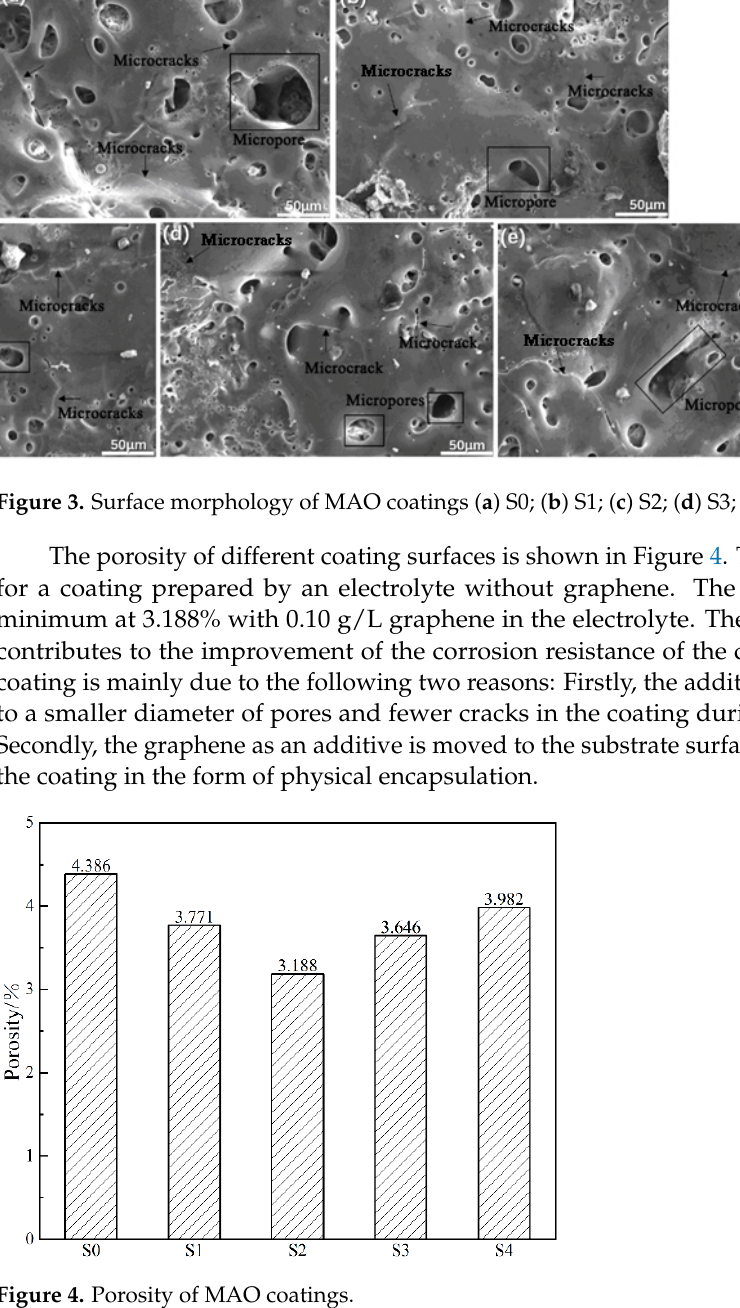
Figure 5. Cross-section morphology of MAO coatings ( a ) S0; ( b ) S1; ( c ) S2; ( d ) S3; ( e ) S4. 3.3. Phase Compositions XRD patterns of the MAO coatings with different graphene additions in the elec- trolyte are shown in Figure 6. It is evident from the figure that the coatings were mainly composed of rutile TiO 2 and anatase TiO 2 . Notably, the chemical compounds associated with the graphene in the electrolyte and titanium were not detected in the coatings, which meant that the coatings were compact. The XPS results of MAO coating on S4 were shown in Figure 7. With graphene (0.2 g/L) in the electrolyte, a peak of carbon was de- tected, indicating that the C entered the coating. The peak binding energies of C1s are 284.72 eV, 286.79 eV, and 288.47 eV, respectively, corresponding to C-C, C-O-H, and O-C=O chemical bonds. This means that the C appeared as these chemical bonds in the MAO coating. This is due to the graphene’s oxidation or reaction with the electrolyte during the micro-arc oxidation process. Rutile TiO 2 and anatase TiO 2 phases are different crystal types of TiO 2 . Rutile TiO 2 is a relatively stable crystal type, while anatase TiO 2 can be transformed into a more stable rutile TiO 2 under certain conditions. After the addition